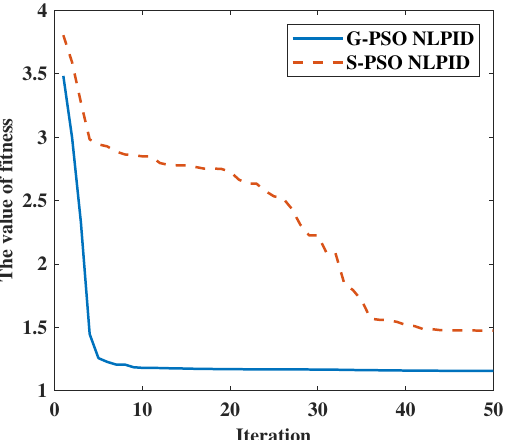
Figure 7. Convergence comparison of S-PSO NLPID and G-PSO